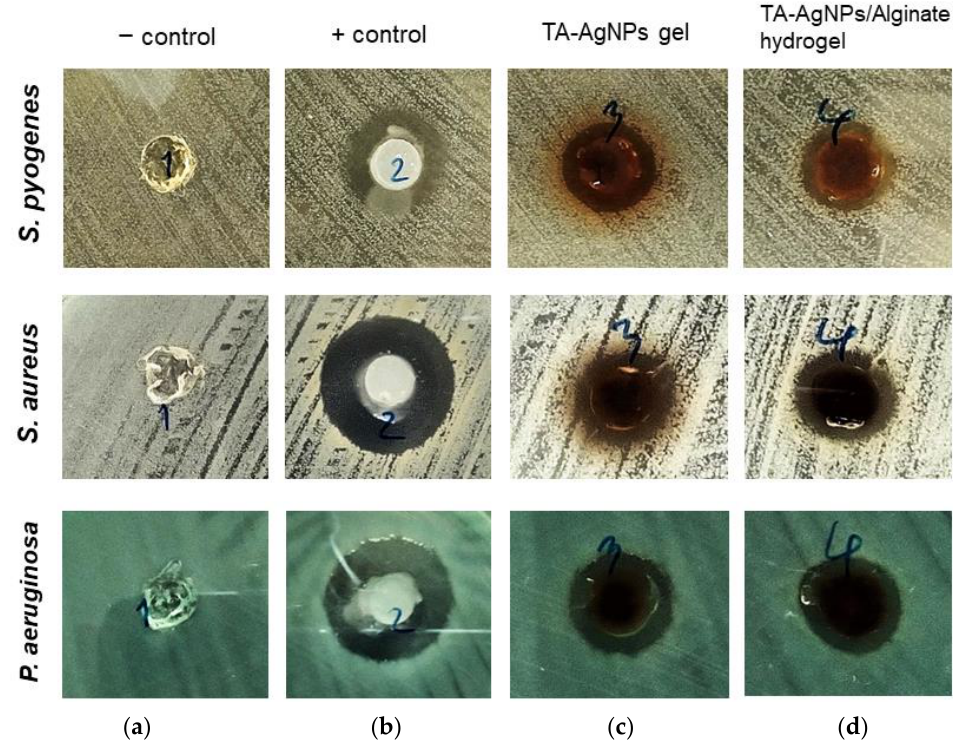
Figure 4. Diameter of zone of inhibition (mm): S. pyogenes (top); S. aureus (middle); and P. aeruginosa (bottom), inset: No.1: 1% alginate gel control (negative control) ( a ); No.2: antibiotic ointment (posi- tive control, Neosporin ® ) ( b ); No.3: 512 µg/mL of TA-AgNPs gel ( c ); and No.4: 512 µg/mL of TA-AgNPs/Alginate hydrogel ( d ). Table 4. Diameter of zone of inhibition of TA-AgNPs gel against bacteria causing wound infection.